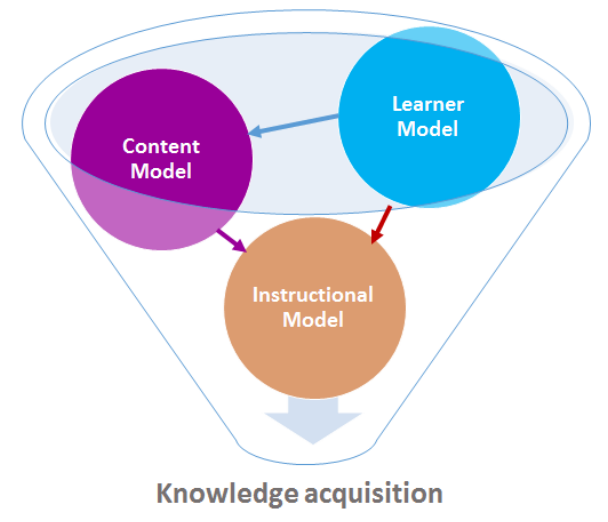
Figure 1. Bloom’s Taxonomy Framework.